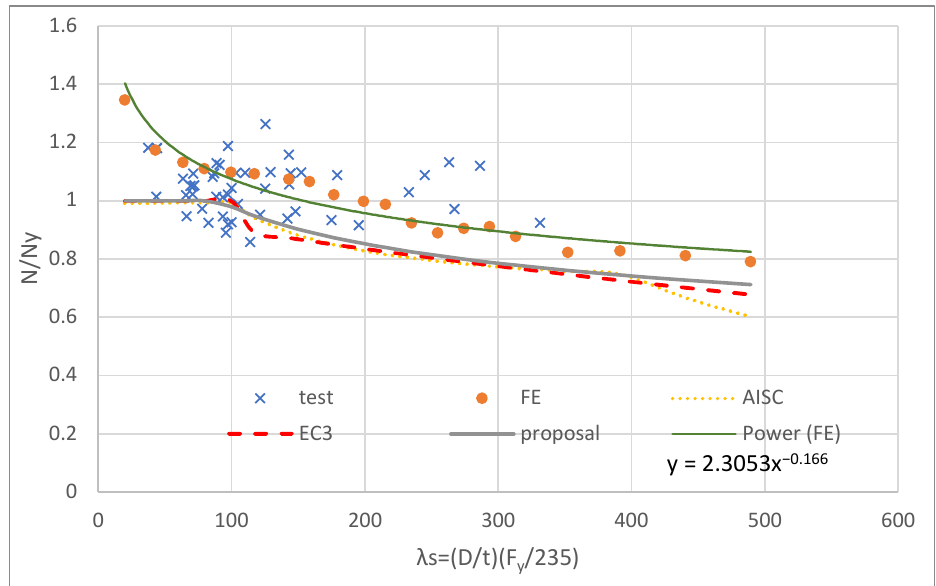
Figure 19. Comparison of normalized static axial load versus section slenderness between the proposed design equation, experimental results by others, FE by authors, and the predicted values of AISC and EC3 standards for HSS-S460.